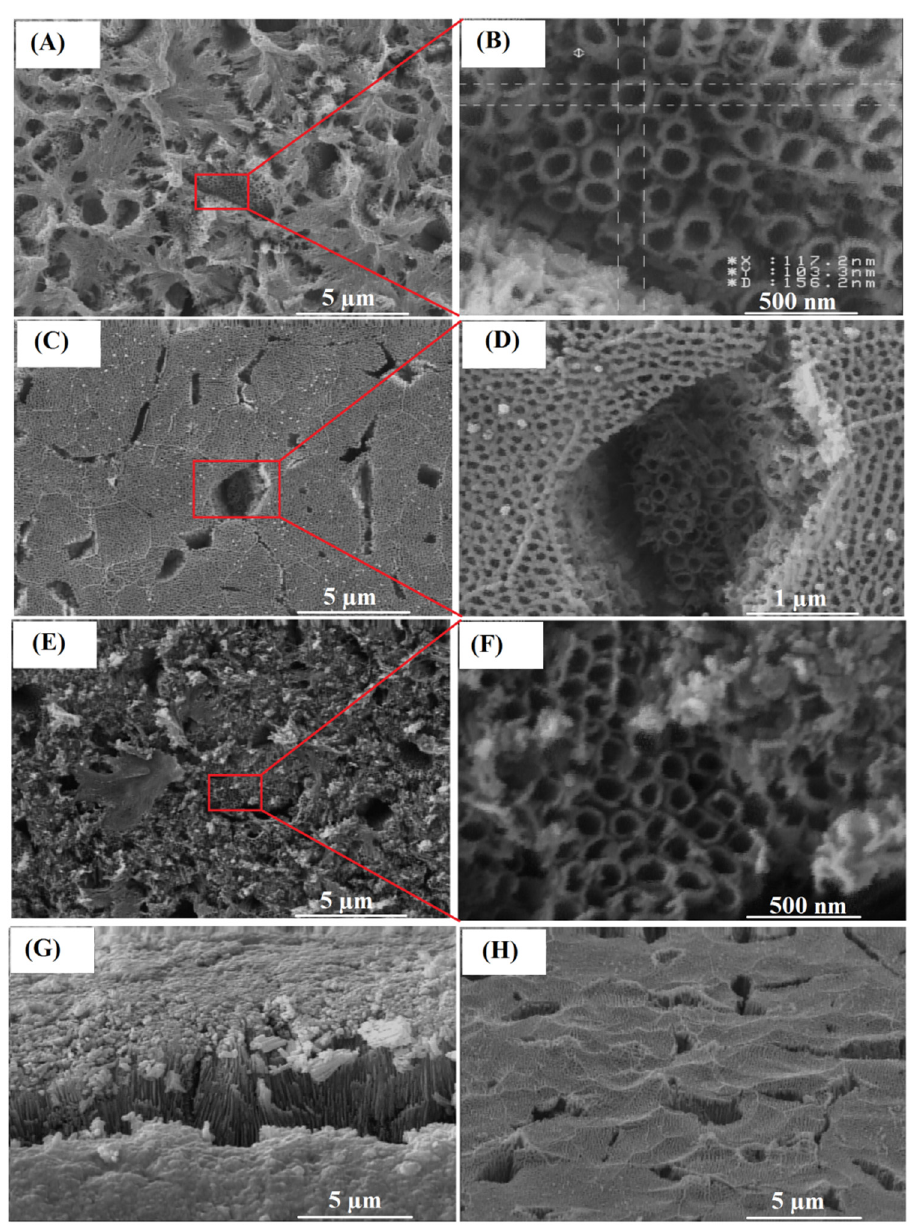
Figure 1. SEM images of decorated CT with Pt photo-deposition: Pt-CT-1 ( A , B ), Pt-CT-2 ( C , D ), Pt-CT-4 ( E , F ) at different magnitude, the red lines show the selected part of SEM images at higher magnitude, cross section ( G ), and side view ( H ) of Pt-CT-6.